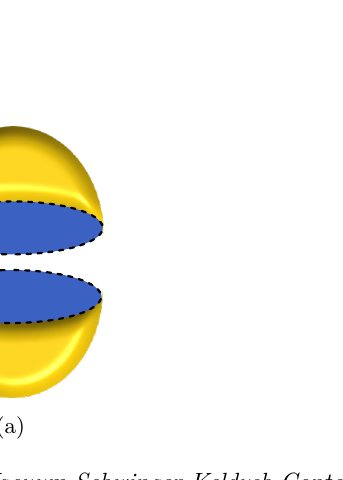
Figure 14 . AdS 3 Vacuum Schwinger-Keldysh Contour . String amplitudes for AdS 3 in the spacetime vacuum state compute vacuum expectation values of the dual CFT and are defined by continuation from SL(2 , C ) k / SU(2) . The Euclidean amplitudes compute BCFT correlation functions on the S 2 conformal boundary of EAdS 3 , with insertions at the points ( x, ¯ x ) which labeled the worldsheet vertex operators. The spacetime is complexified and the insertions continued to the Lorentzian section to obtain vacuum expectation values. Though the procedure does not rely on a Lagrangian, one may think of these amplitudes as defined by a worldsheet functional integral along the Schwinger- Keldysh contour in target space shown. A Euclidean cap (in yellow) prepares the AdS 3 vacuum, which is glued to a Lorentzian excursion (in blue) that flows forward and backward in time, and is then glued to the outgoing vacuum cap. String vertex operators insert dual operators on the conformal boundary, indicated by the red × ’s. Operators may also be left on the Euclidean caps to define string perturbation theory in AdS 3 in different excited pure